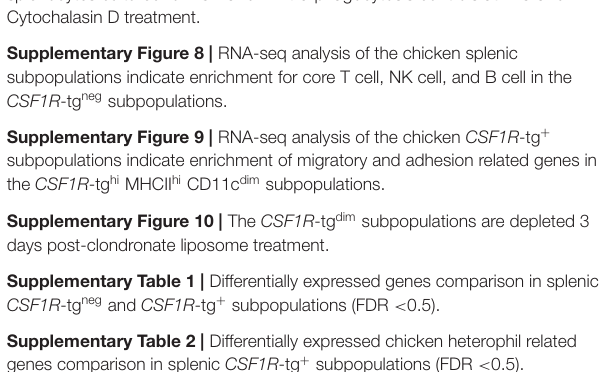
Supplementary Figure 5 | Phenotypical analysis of the CSF1R -tg neg MRC1L-B + cells in the chicken spleen and thrombocyte cell analysis.